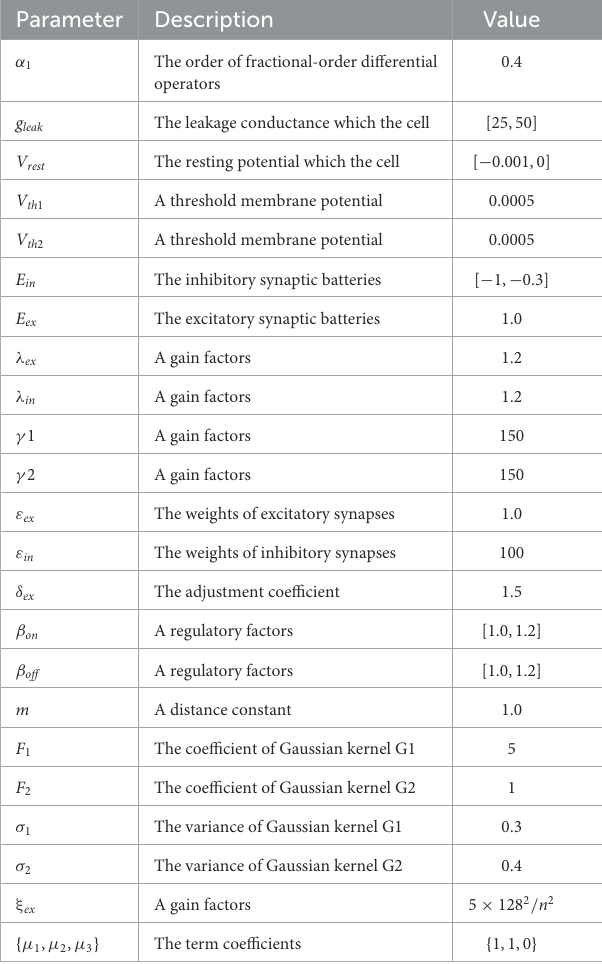
TABLE 1 Setting parameters of the proposed DFLGMD